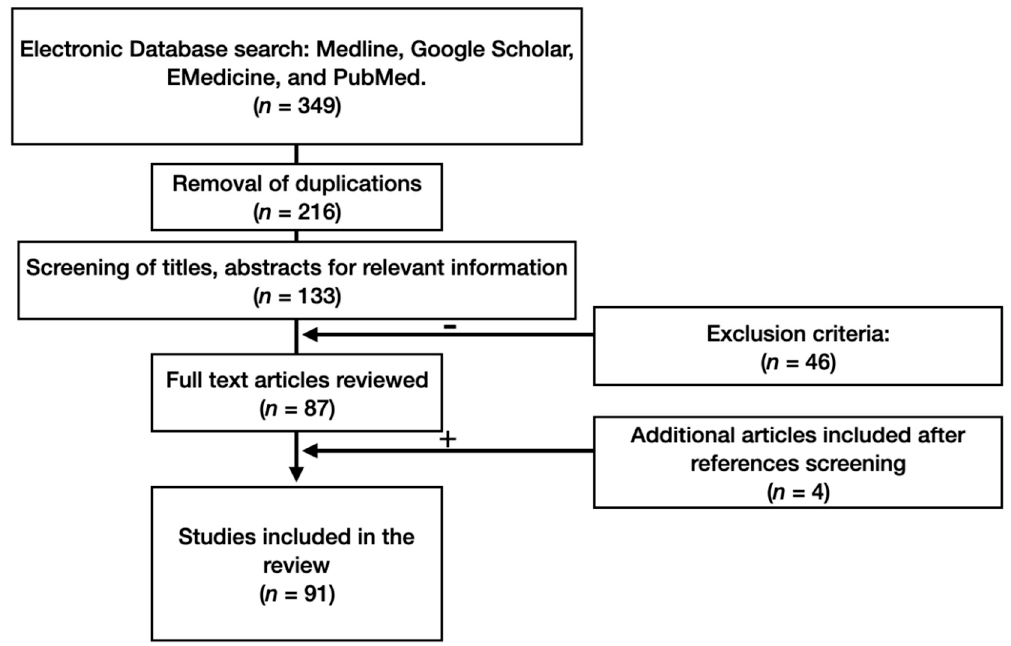
Figure 1. Flow-chart of study methodology.